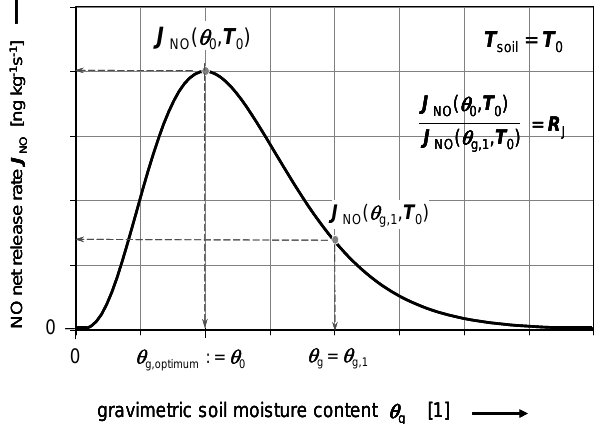
Figure 3. Schematic of NO net release rate J NO vs. gravi- metric soil moisture θ g at constant soil temperature. The ratio Fig. 3: Schematic of NO net release rate J NO vs . gravimetric soil moisture  g at constant J NO (θ 0 )/J NO (θ g,1 ) = R J is chosen arbitrarily (without loss of soil temperature. The ratio J NO (  0 ) / J NO (  g,1 ) = R J is chosen arbitrarily (without loss of generality).